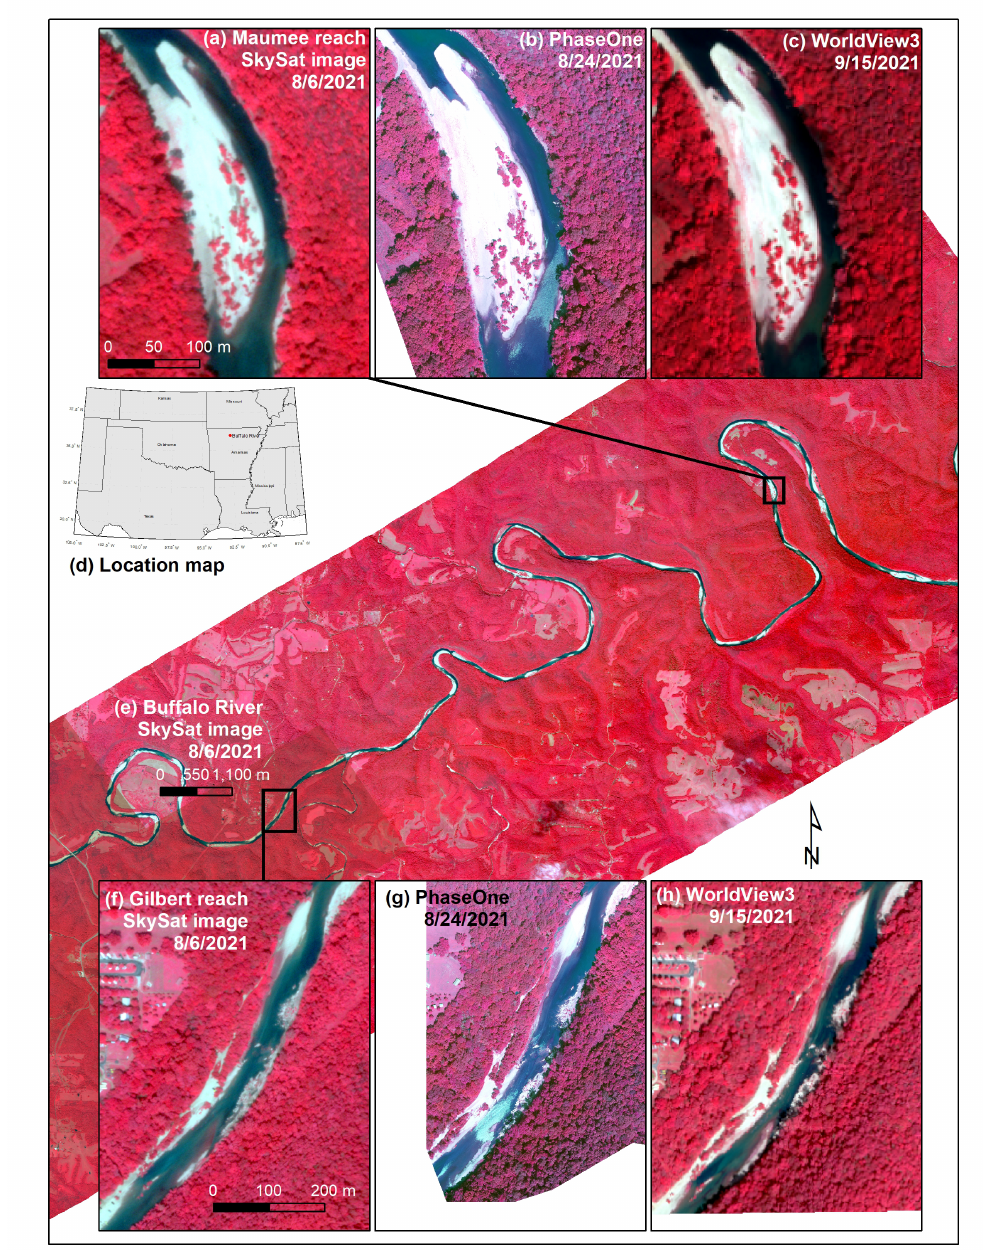
Figure 2. Study area along the Buffalo National River in northern Arkansas, USA. False-color infrared images (near-infrared band displayed as red, red band displayed as green, and green band displayed as blue) from each type of sensor evaluated in this study are shown in ( a – c ) for the Maumee reach and in ( f – h ) for the Gilbert reach. An inset map indicating the location of the Buffalo River within the south-central United States is provided in ( d ) and an overview of the study area is shown in ( e ). The overall flow direction is from west to east, which is from the bottom to the top of the images in ( a – c ) and from left to right in the images in ( e – h